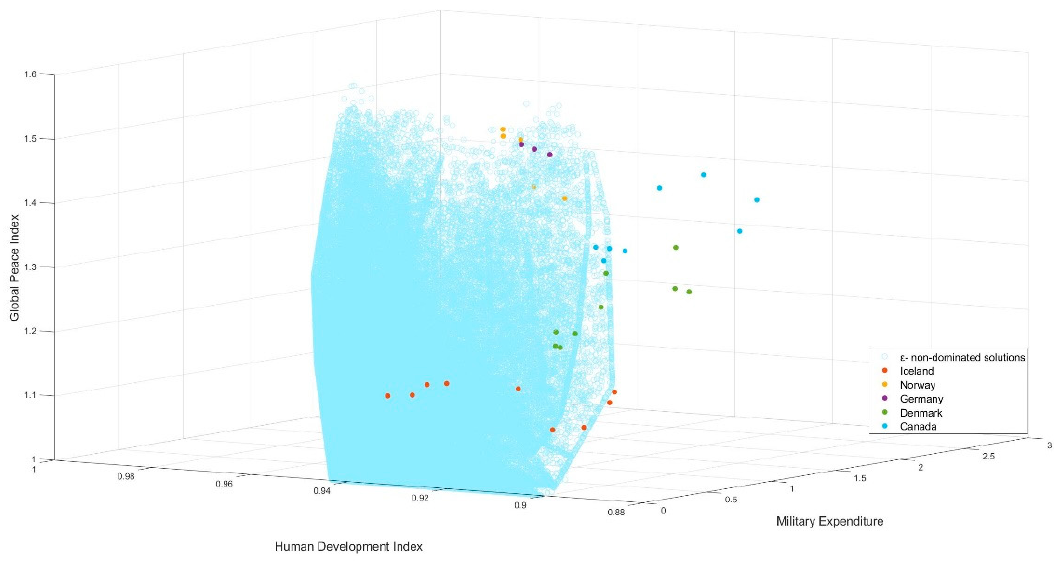
Figure 4. Situations of a subset of countries with respect to the ε -Pareto front.